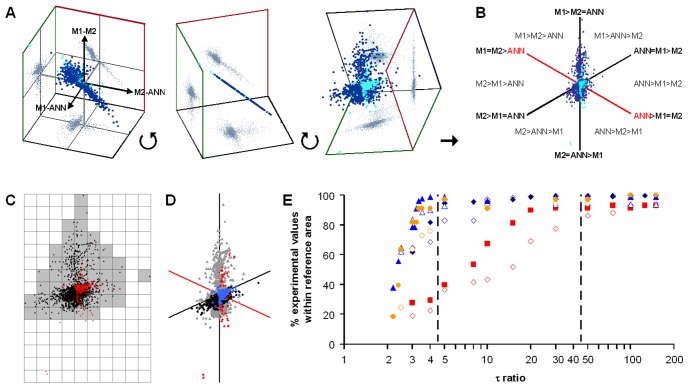
Similarity diagrams for the evaluation of M1, M2 and ANN precision.
A) Differences between estimates (M1–M2, M1-ANN, M2-ANN) were calculated for experimental data (light blue) as well as for the 2×1000 benchmark spectra (dark blue) and normalized with respect to the estimated (measured spectra) or target (modeled spectra) Repi values. Plotting these differences on the three axes of a three-dimensional coordinate system yielded a distribution with all data points falling onto a single plane within the three-dimensional space. Grey dots represent projections of the data points onto the three planes. 3D scatterplots were created with Excel macros provided by Gabor Doka (http://www.doka.ch/Excel3Dscatterplot.htm). B) Data points were transformed to present this plane in a two-dimensional similarity diagram with three axes. Data scatter along the red axis indicates a greater dissimilarity of values obtained with the appropriate ANN when method M1 and M2 yield very similar results. Data are derived from spectra generated for Rsub estimation of HT-29/B6 cells in the absence of EGTA. C) Shaded “reference” area, indicating the area covered by data points (black ▴) shown in (A), was determined in a 10 by 10 grid. 276 of 281 (98.2%) of the data points from measured spectra (red ♦) are contained by the reference area, indicating that the model spectra were generated for appropriate parameter ranges (see also Fig. S7). D) Distribution of data points from modeled spectra with τ ratios <5 (black ♦) is similar to the distribution of data points from measured spectra (blue •) obtained in the absence of forskolin or nystatin. Conversely, distribution of data points from model spectra with τ ratios >5 (grey ▴) is similar to the distribution of data points from measured spectra (red ♦) obtained in the presence of forskolin or nystatin. This indicates that τ ratios of measured spectra can be estimated from the distribution of data of model spectra with known τ ratios. Axes as in B. For all other conditions see Fig. S6. E) Estimating τ ratios of measured HT-29/B6 spectra before and during forskolin or nystatin application. Data points from spectra obtained in the absence of any drugs (no EGTA, nystatin or forskolin; blue ♦, Repi; blue ⋄, Rsub) showed highest similarity with those of modeled spectra with τ ratios ≤ 4.5. In contrast, τ ratios of up to ∼50 were needed to model data points from spectra obtained in the presence of forskolin or nystatin but absence of EGTA (red ▪, Repi; red □, Rsub). If Rtrans was short-circuited by an EGTA-induced decrease in Rpara, all spectra assumed near semicircular shapes, irrespective of the absence (blue ▴, Repi+EGTA; blue ▵, Rsub+EGTA) or presence (yellow •, Repi+EGTA; yellow ○, Rsub+EGTA) of forskolin or nystatin.